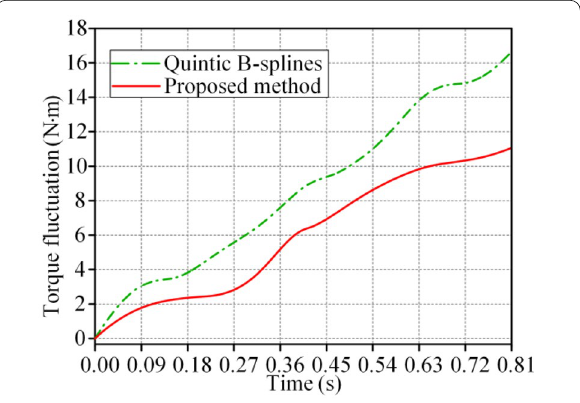
Figure 12 Comparison chart of torque